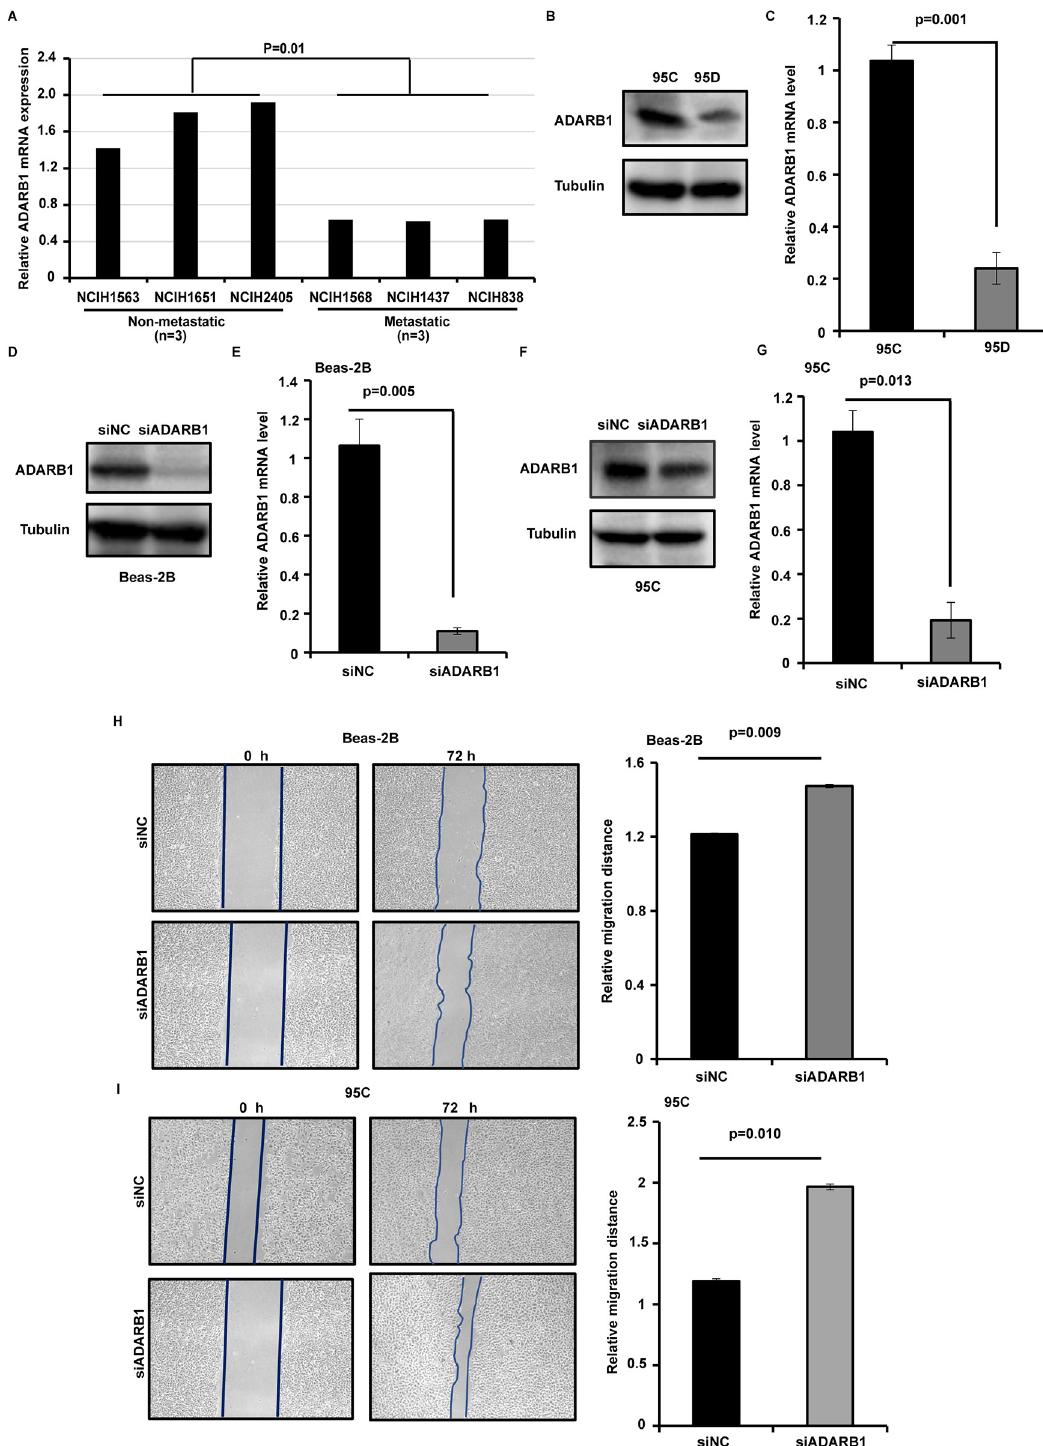
Fig 3. ADARB1 could suppress LUAD cell metastasis. (A) The CCLE database showed lower levels of ADARB1 in metastatic LUAD cells. Western blot (B) and RT-PCR (C) analyzed the expression of ADARB1 in 95C and 95D cells. The protein levels of ADARB1 after transfected with siADARB1 in Beas-2B (D) and 95C (F) cells. The mRNA levels of ADARB1 after transfected with siADARB1 in Beas-2B (E) and 95C (G) cells. The results of wound healing assay after transfected with siADARB1 in Beas-2B (H) and 95C (I)